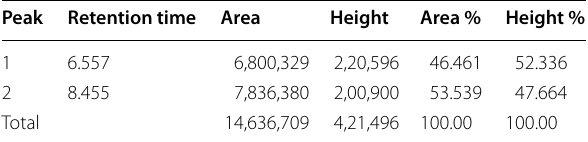
Table 3 HPLC data of ( RS )-α-methyl benzyl amine before catalysed by ( R )-specific